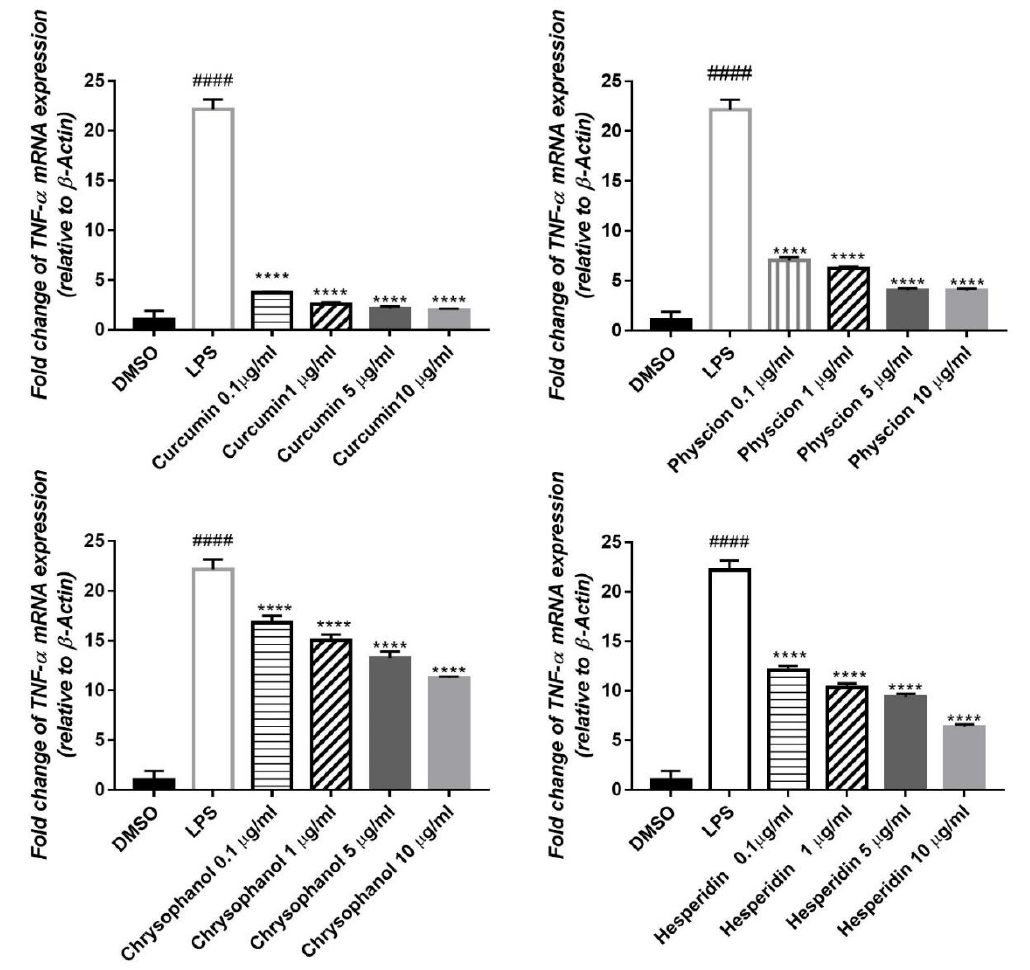
Figure 3. Effect of the isolated compounds (1–4) on the elevated level of TNF-α in HepG2 cells induced by 1 μg/mL LPS relative to β-Actin. qPCR was used for estimation of mRNA expression. Results are expressed as ± S.E ( n = 3), #### p < 0.0001 compared with control. **** p < 0.0001 compared to LPS.